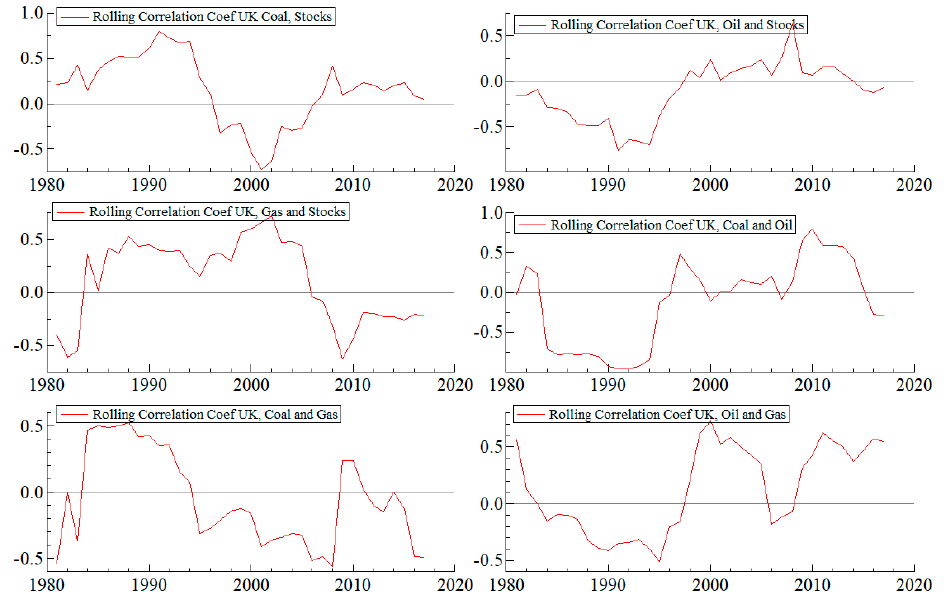
Figure 2. Ten-year rolling window correlations for the UK.